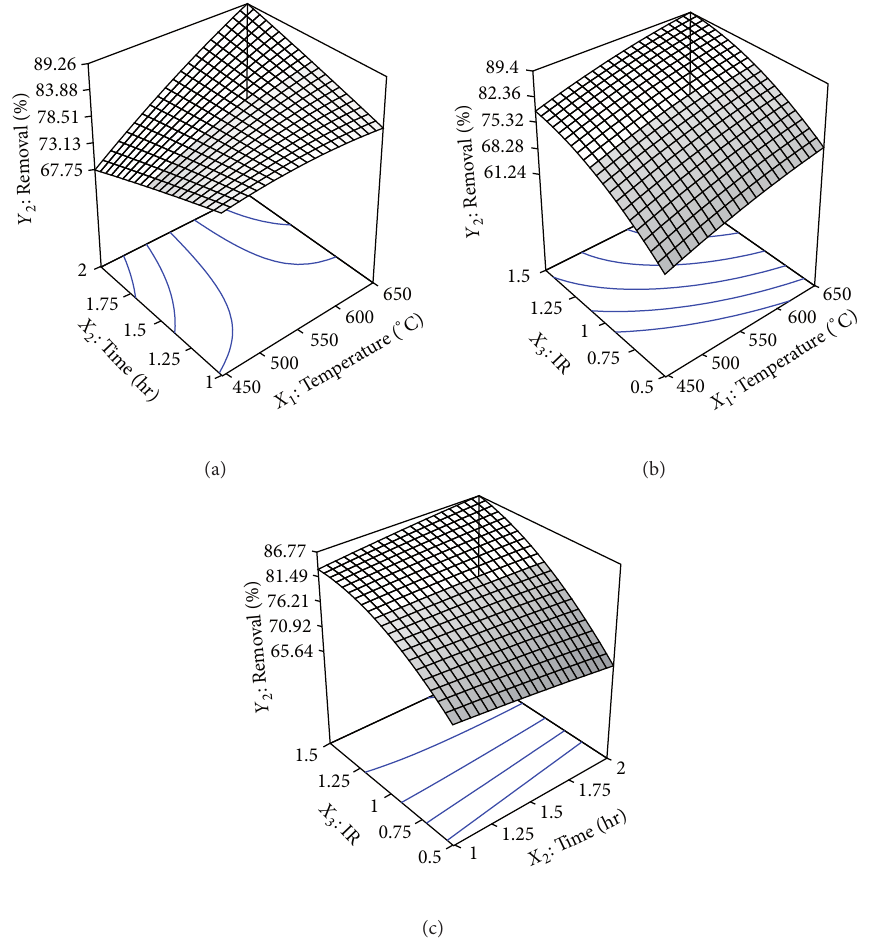
F 2: ree-dimensional response between the variables activation temperature, time and IR for the removals of methylene blue onto BPAC, (a) the variables activation temperature and activation time, (b) the variables activation temperature and IR, and (c) activation time and